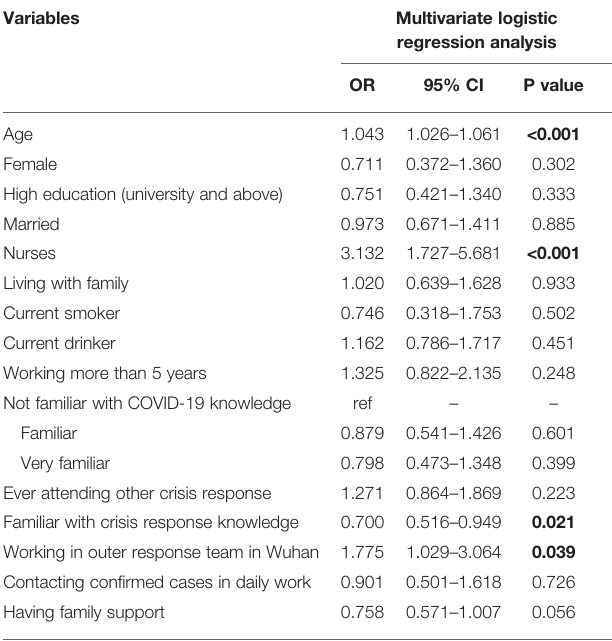
TABLE 3 | Independent correlates of poor sleep quality by multivariate logistic regression analysis.